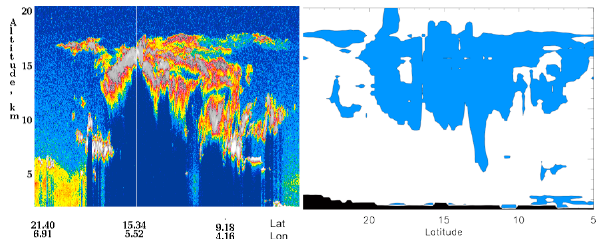
Fig. 6. Left: CALIPSO aerosol backscatter observed at 01:30UTC on 11 August. Aerosol observations (not shown) shows that aerosol are in solid phase. Right: relative humidity with respect to ice es- timated from BOLAM along the CALIPSO overpass. Shaded area shows where relative humidity exceeds